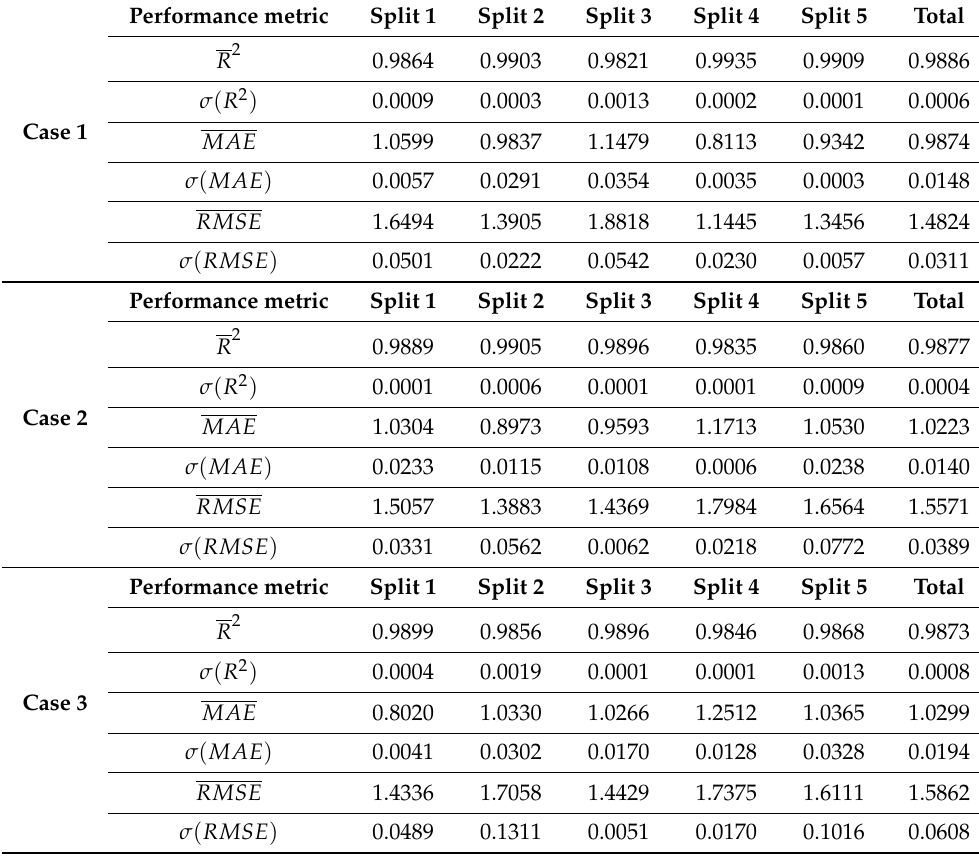
Table 5. The mean and σ values of R 2 , MAE , and RMSE were achieved in a 5-fold cross-validation process.